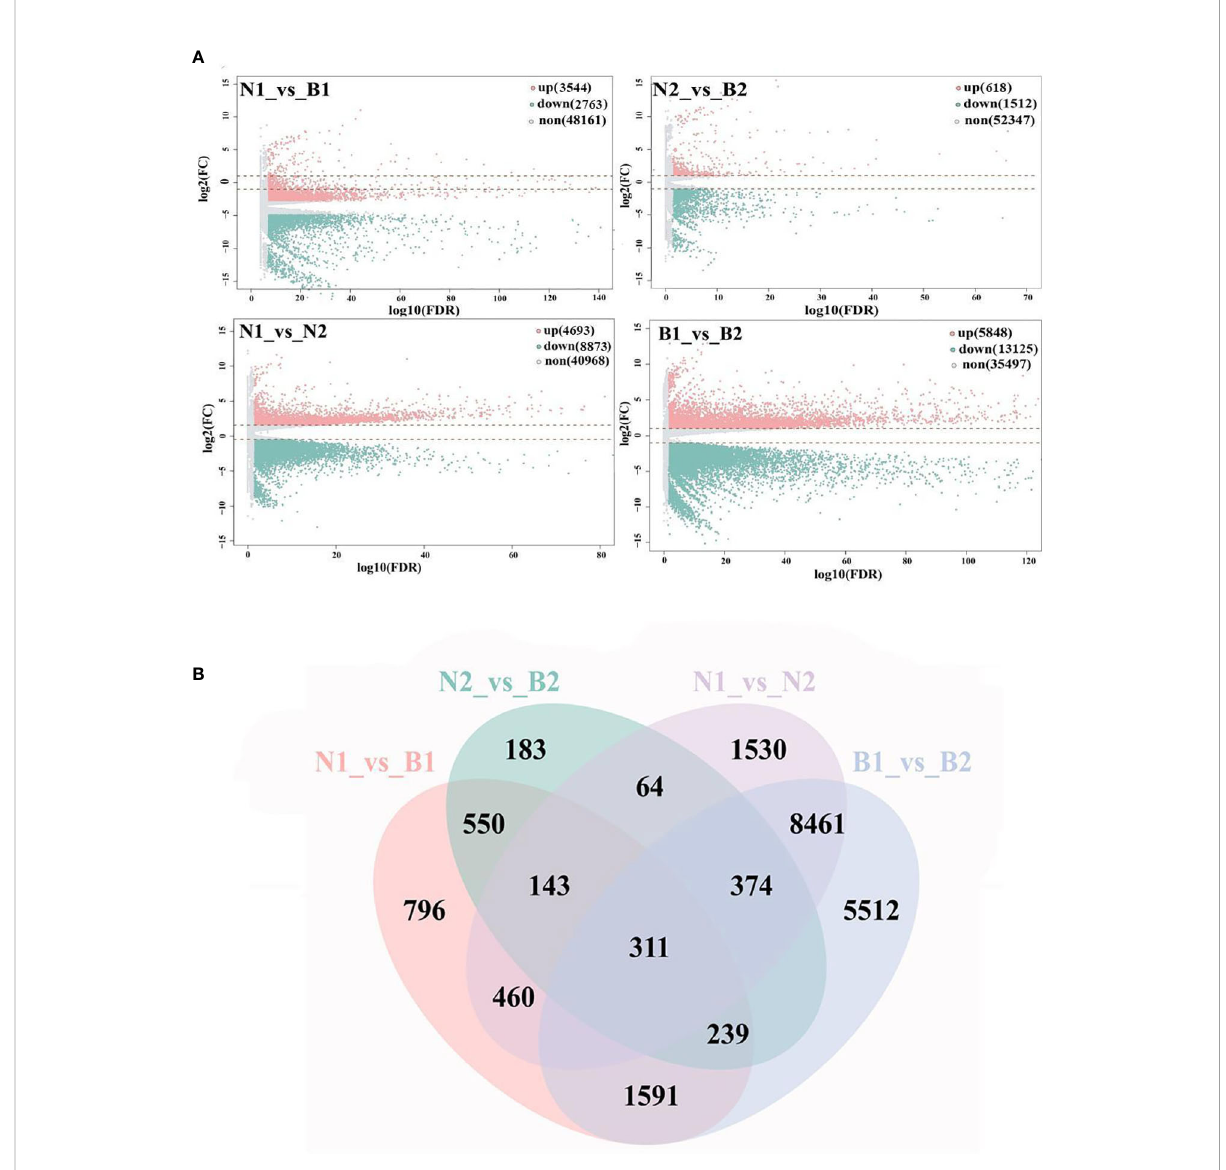
FIGURE 1 Screening and enrichment analyses of differentially expressed genes (DEGs). Volcano map (A) shows the DEGs identi fi ed from the N1_ vs _B1, N2_ vs _B2, N1_ vs _N2, and B1_ vs _B2. Up, down, and none in panel (A) mean the upregulated genes, downregulated genes, and no-expressed genes and are indicated in pink, green, and gray, respectively. The values at the top right indicate the number of upregulated, downregulated, and non-differential expression genes. The abscissa shows the false discovery rate (FDR) (-log10), and the ordinate shows the log2(FC). The Venn diagram (B) shows the overlapping of DEGs in the above four comparison groups. The numbers on the overlapping non-colored and colored parts indicate the DEGs in a single comparison group and the DEGs shared among different comparison